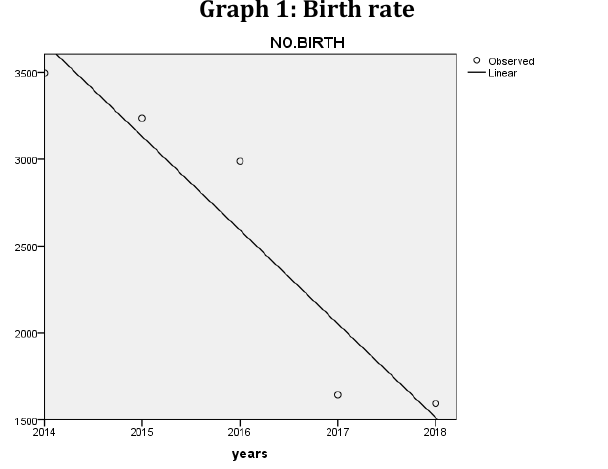
Populatio The growth rates n population/percen increasin tage g percenta ge